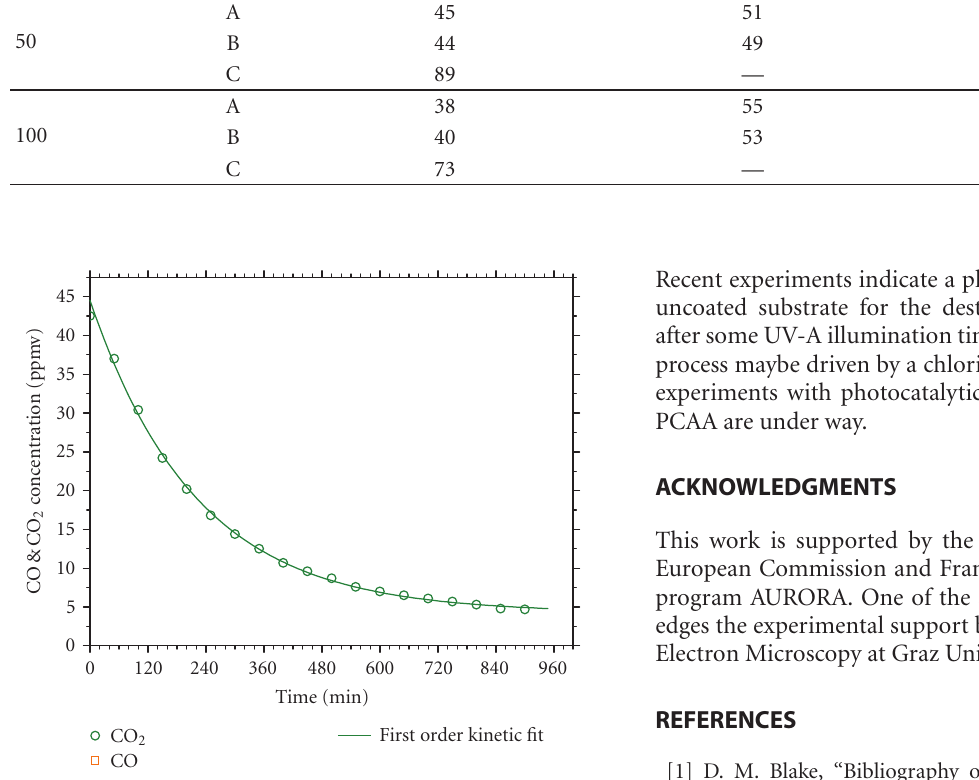
Figure 7: Transient CO, CO 2 concentration at reactor outlet for a long-term regeneration run. The measured data points were fitted with a first-order kinetic fit